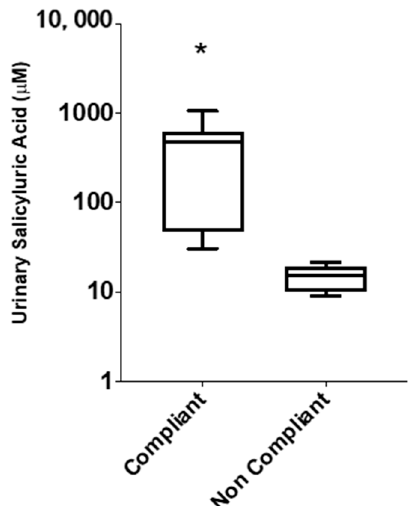
Figure 4. Box-whisker plots depicting distribution of urinary salicyluric acid (SU) concentrations in ASA compliant ( ≥ 27 µM, n = 9) and ASA non-compliant (<27 µM, n = 8) patients, based on absolute concentrations (µM) measured from single-spot urine samples. Significant difference of SU levels between compliant and non-compliant patients is represented by (*) with p < 0.05.